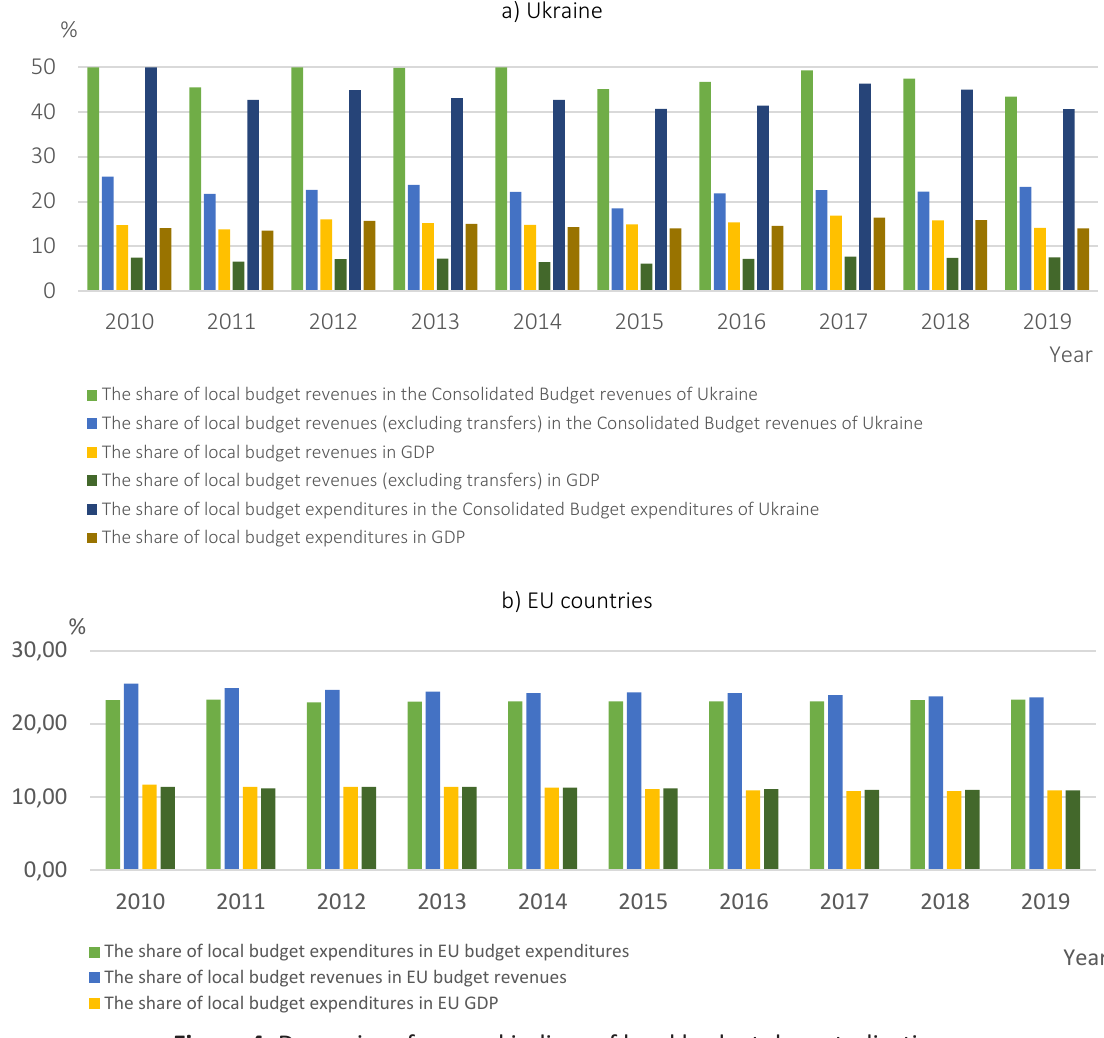
Figure 4. Dynamics of general indices of local budget